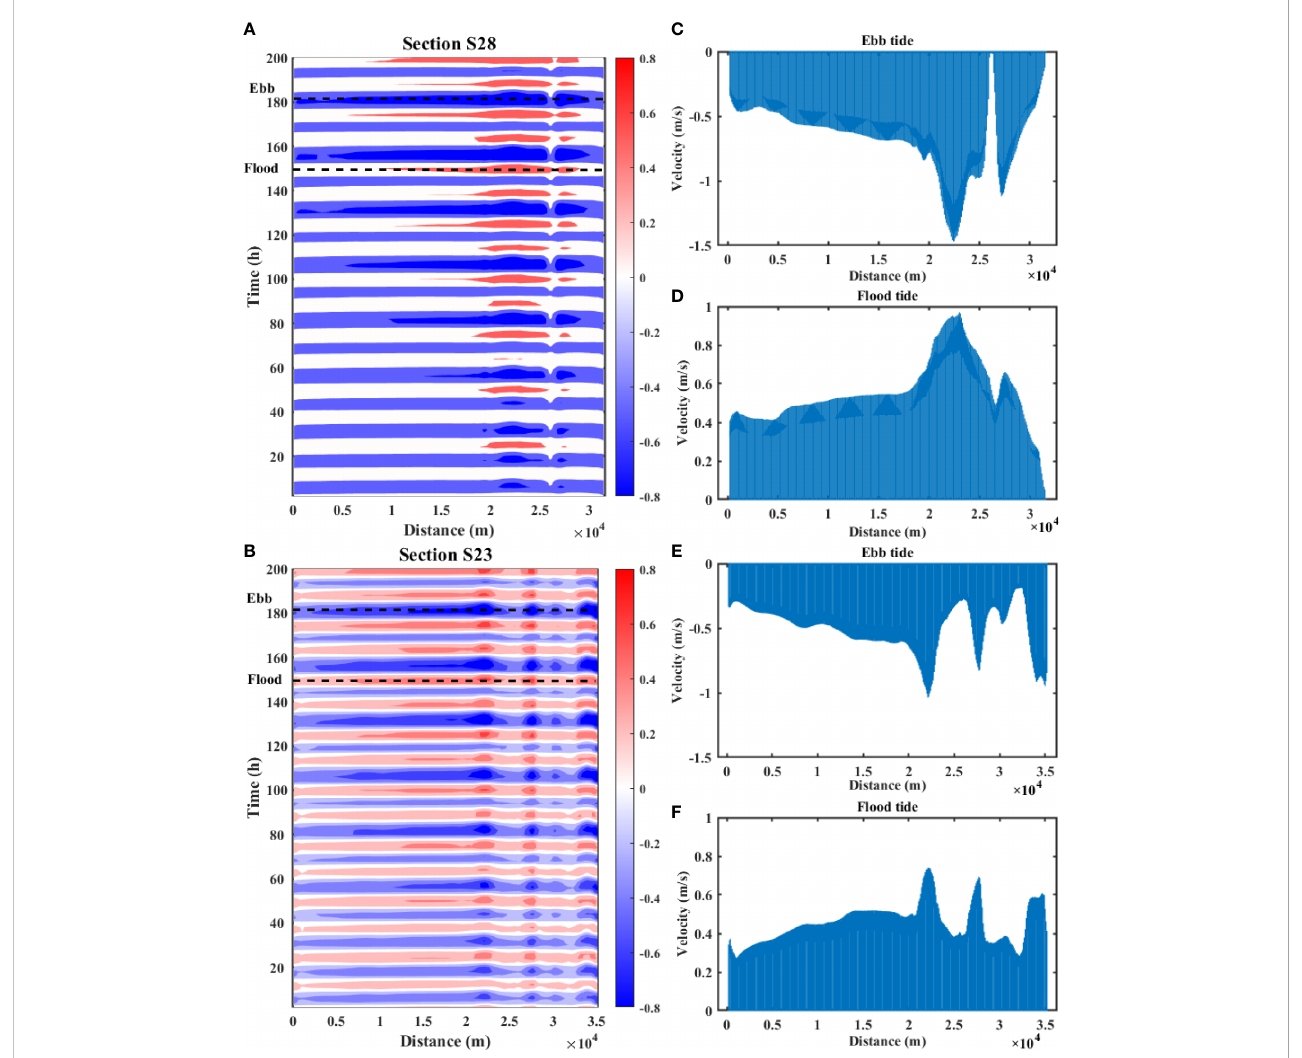
FIGURE 5 Depth-averaged velocity normal to the sections. Contours showing the change of section velocity of S28 (A) and S23 (D) with the tidal cycles. Section velocity of S28 at ebb tide (B) and fl ood tide (C) whose time points are indicated in panel A, whereas time points of section velocity of S23 at ebb tide (E) and fl ood tide (F) were are in (D)